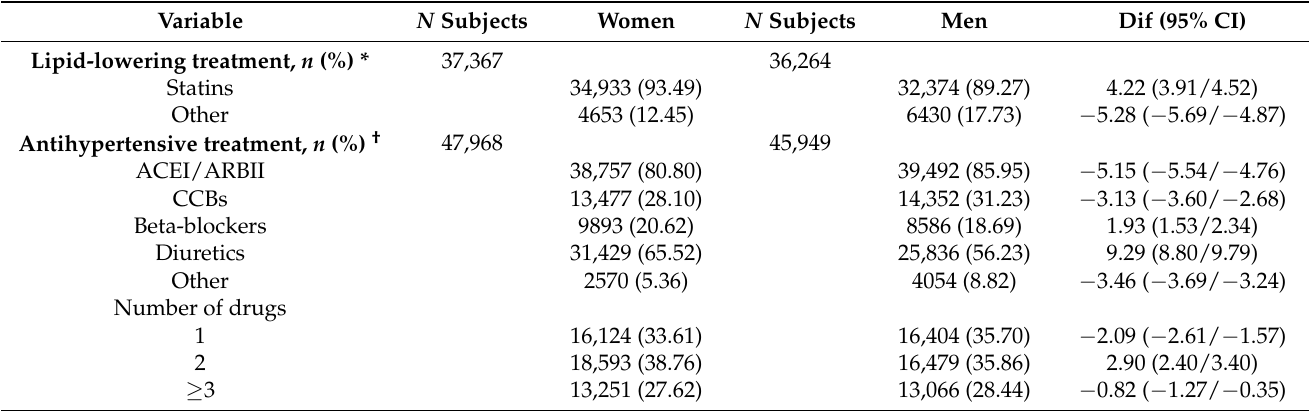
Table 2. Pharmacological treatment and cardiovascular risk factor control in matched women and men with T2DM in primary prevention by